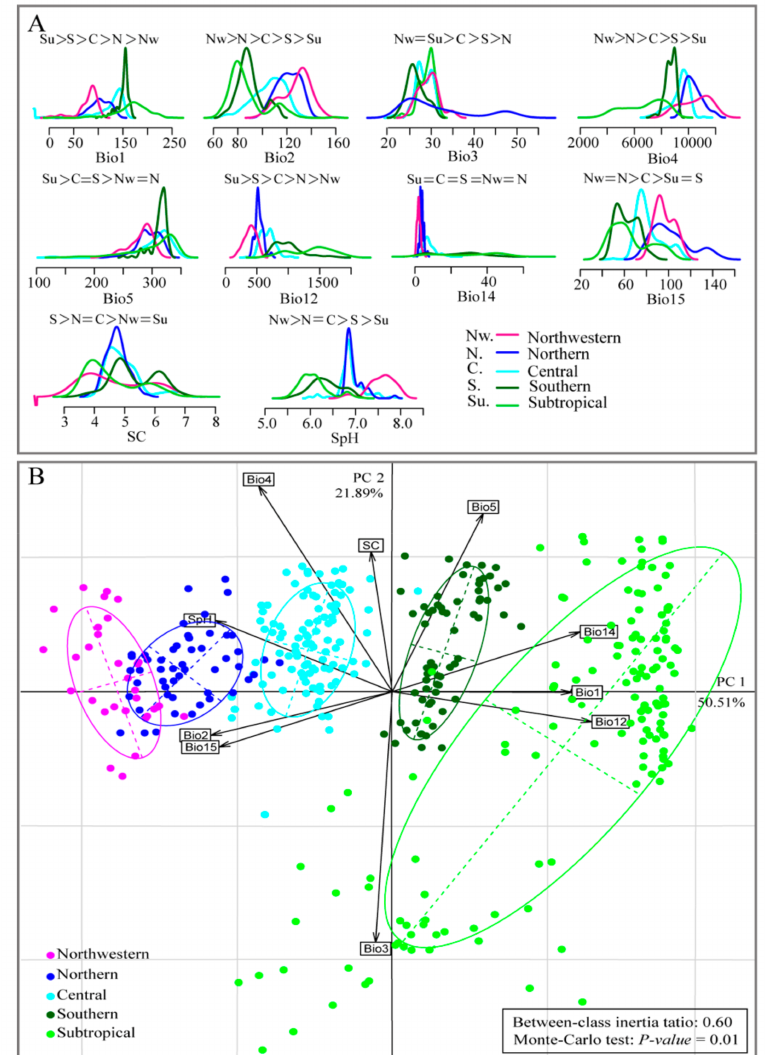
Figure 1. Kernel density plots for 10 environmental parameters of the five seed zones and principal component analysis distance biplot for the 401 occurrences on 10 environmental variables. ( A ) Differentiation among seed zones was evaluated by a Kruskal-Wallis multiple-range test, and the results are indicated in each plot. A lack of significant difference (at the p = 0.05 level) is indicated by an equal sign, while significant differences are coded as either higher or lower; ( B ) The centroids of the 1.5 inertia ellipses for the occurrence groups of five seed zones illustrate the niche shift. See Table 1 for definitions of the